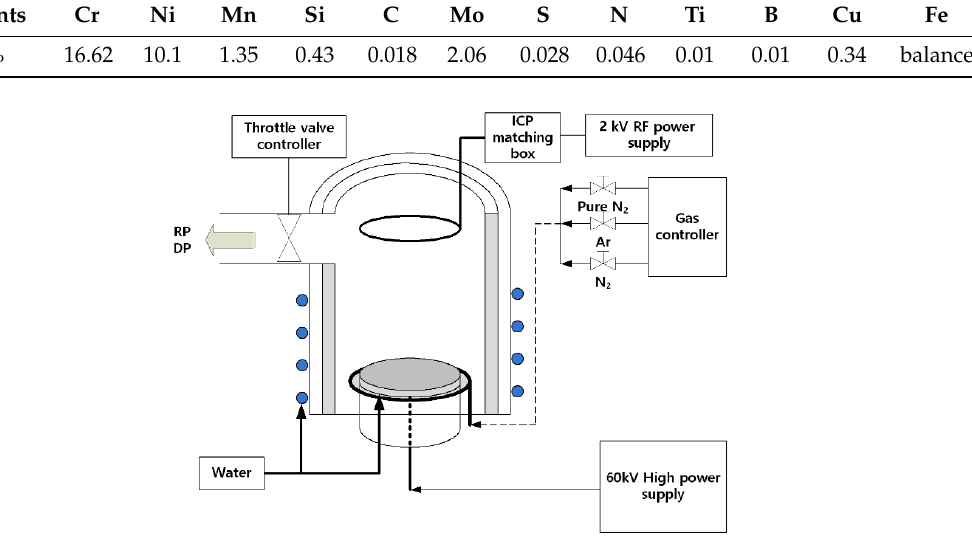
Figure 1. Schematic illustration of the plasma immersion ion implantation system. Table 2. Experimental conditions for N +